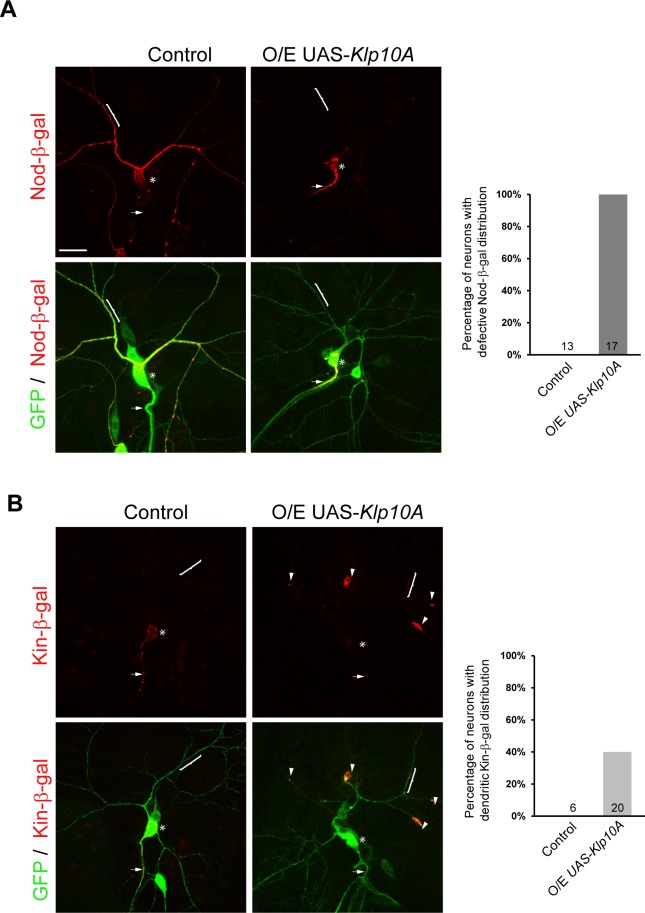
Overexpression of Klp10A causes dendritic MT orientation defects in ddaC neurons.(A–B) Confocal images of ddaC neurons expressing mCD8-GFP, Nod-lacZ or Kin-lacZ and immunostained for β-galactosidase at wL3 stage. ddaC somas are marked by asterisks, axons by arrows and dendrites by curly brackets. (A) Nod-β-gal levels were reduced in the dendrites but enriched in the somas and proximal axons in all Klp10A-overexpressing ddaC neurons. Quantification of the percentage of neurons with defective Nod-β-gal distribution. (B) Kin-β-gal mis-localized to the dendrites in Klp10A-overexpressing ddaC neurons. Quantification of the percentage of neurons with dendritic Kin-β-gal distribution. Scale bar in (A) represents 20 μm. The number of samples (n) in each group is shown on the bars.10.7554/eLife.39964.031Figure 8—figure supplement 1—source data 1.Extended statistical data as Microsoft Excel spreadsheet.